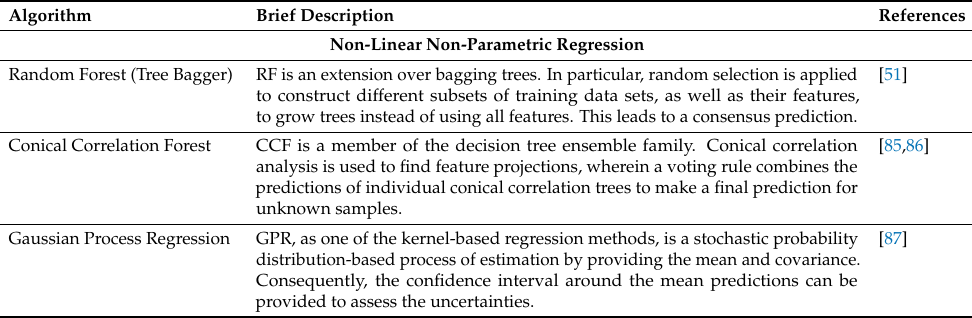
Table 3. List of selected ML methods implemented in ARTMO